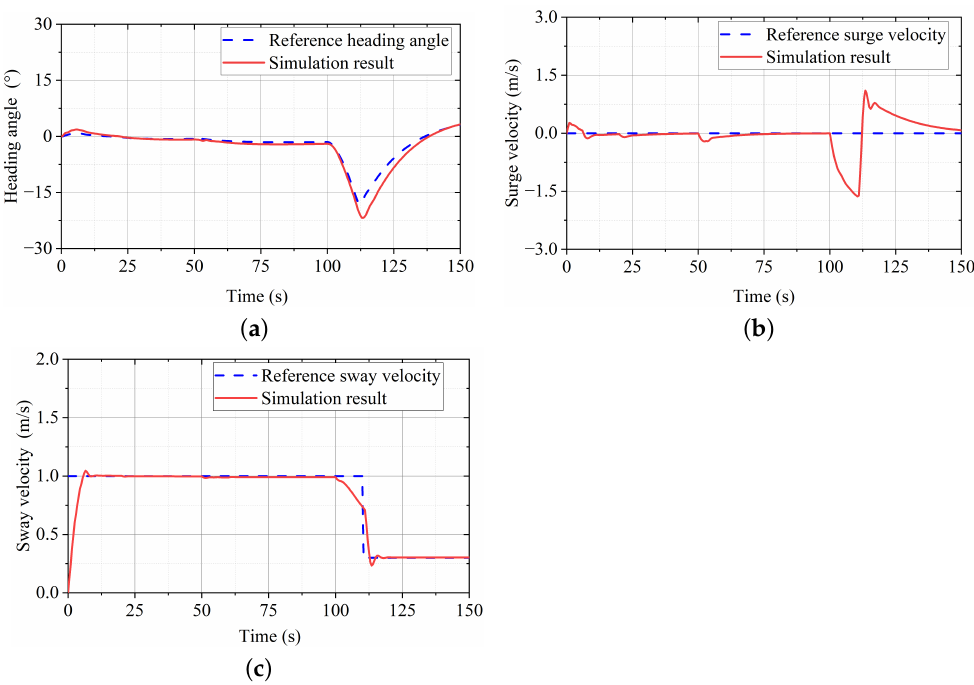
Figure 12. Measurements from navigation system in sideways movement. ( a ) Heading angle following; ( b ) Surge velocity following; ( c ) Sway velocity